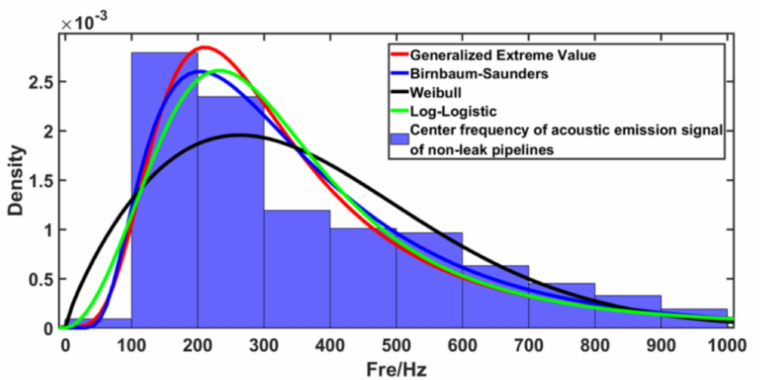
Figure 7. Comparison of the distributions fitting the central frequencies of the acoustic emission signals of the pipeline without a